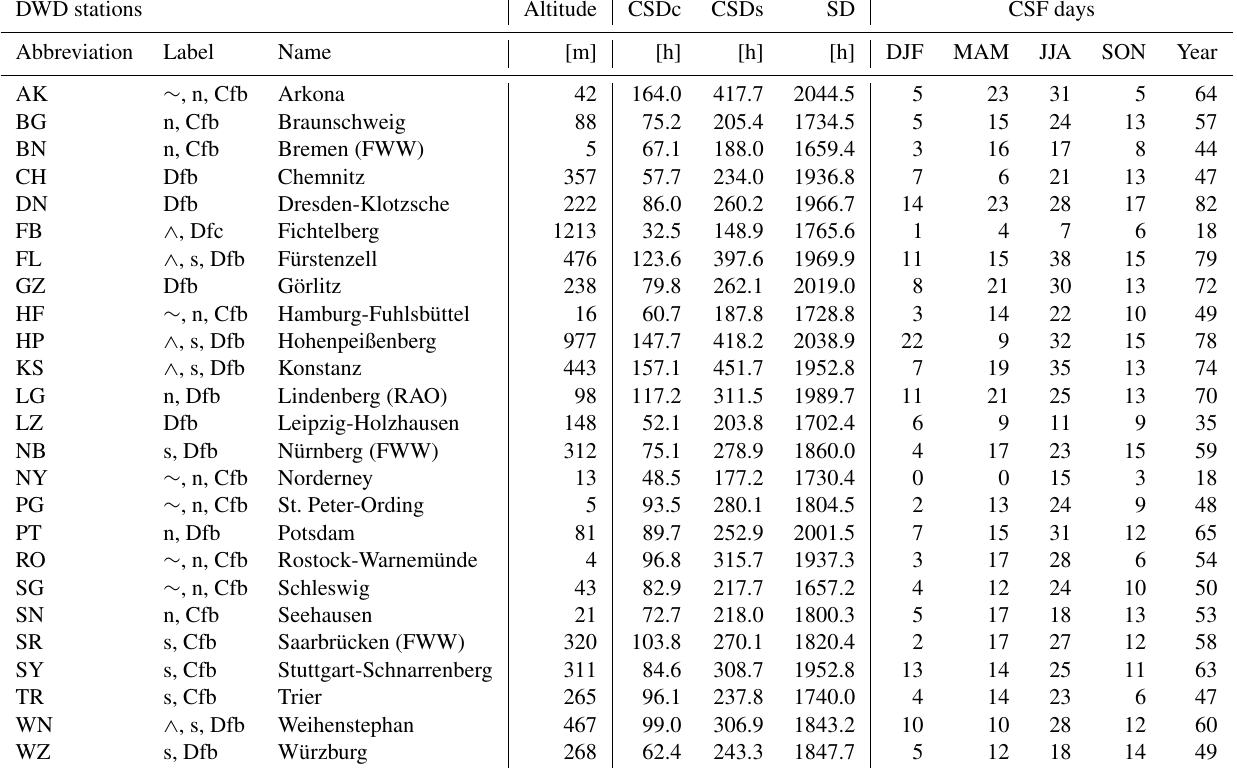
Table 1. Table of available DWD stations with corresponding altitude and selection labels. Hours of clear sky attributed to cloud-free (CSDc) and clear sun (CSDs) are shown in comparison to the WMO sunshine duration (SD). In addition, the number of days feasible for the CSF method are shown for every season and the year